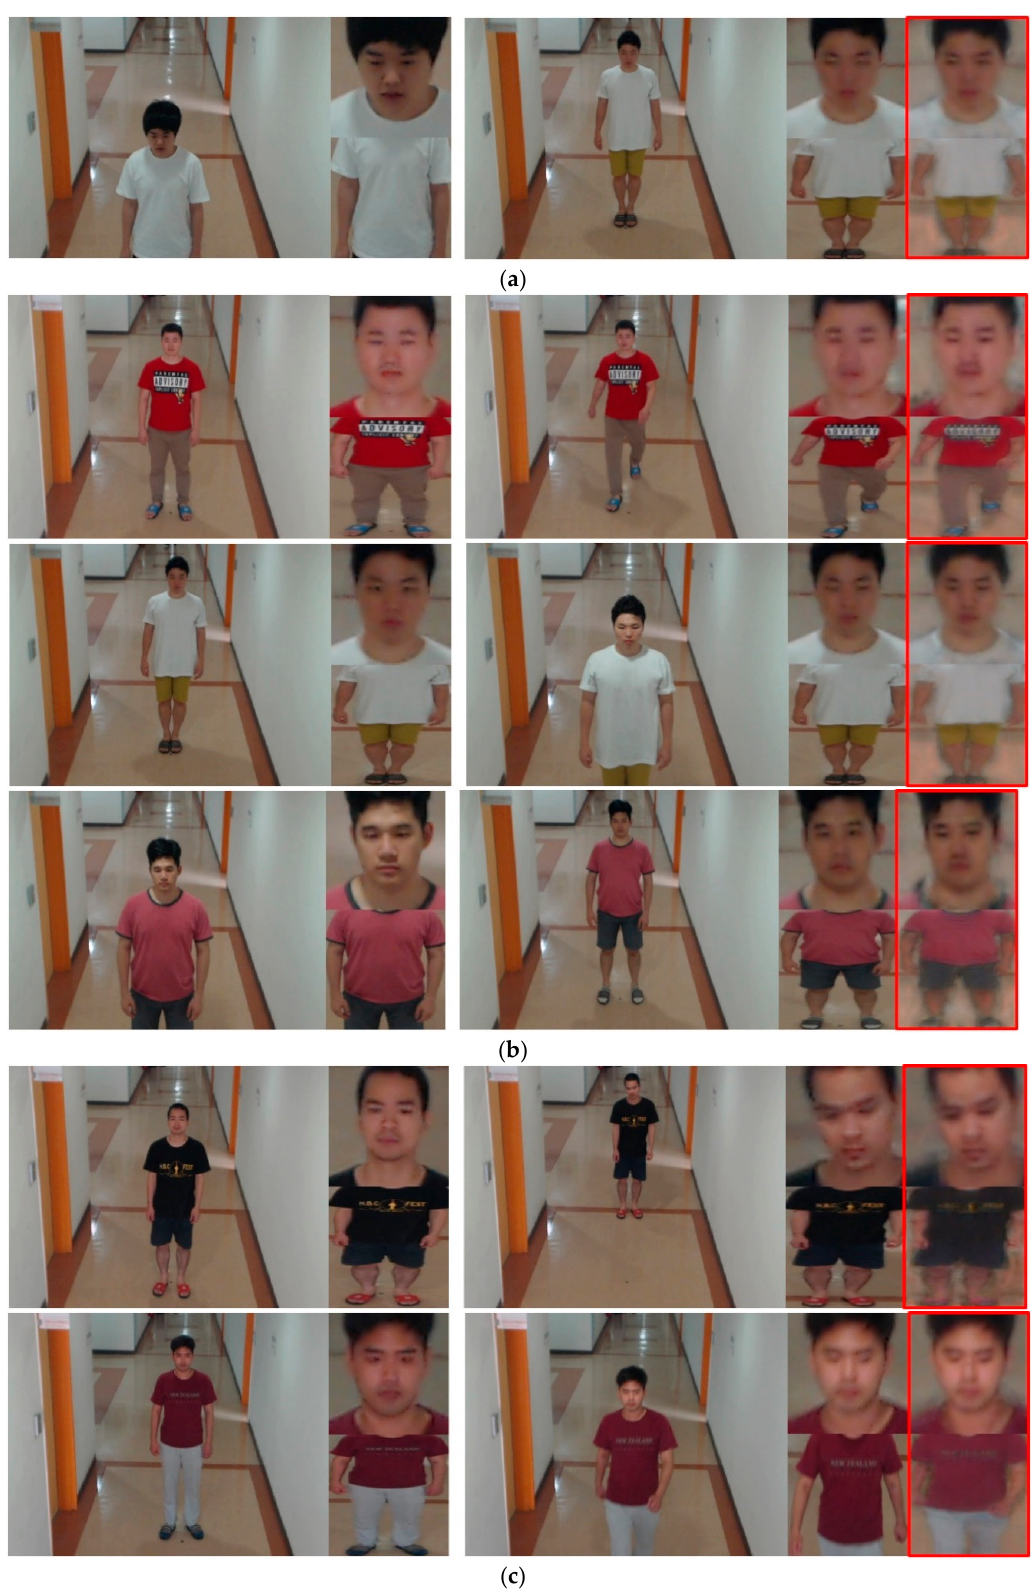
Figure 12. Cases of false acceptance (FA), false rejection (FR), and correction recognition ( a )–( c ) in DFB-DB2. ( a ) FA cases, ( b ) FR cases, and ( c ) cases of correct recognition.